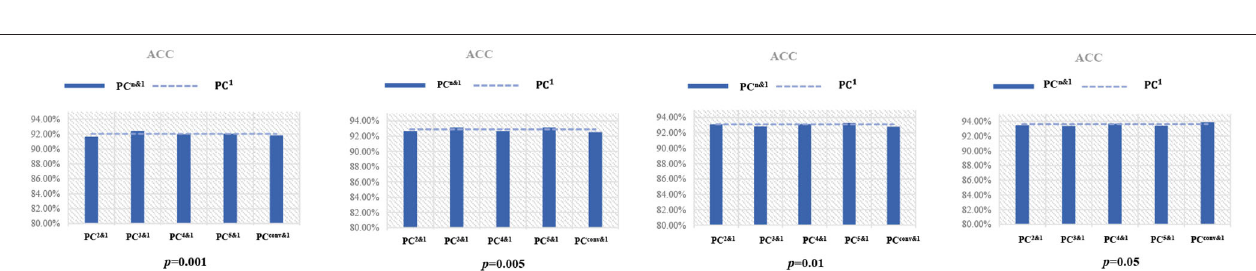
FIGURE 8 | The ACC of gender prediction based on the fusion of PC n -based BFN and PC 1 -based BFN under different p -values. The PC n & 1 corresponds to the fused classification accuracy of PC n and PC 1 , n = 2,3,4, convergence(conv). The dotted line is the ACC of PC 1 itself (without fusion with PC n